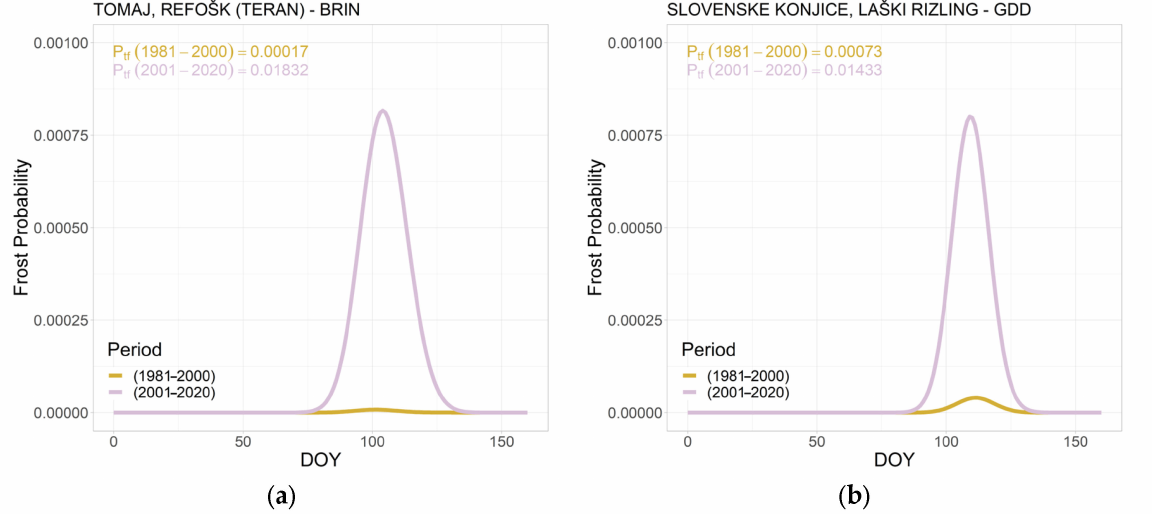
Figure 5. Two examples of modeled results of the probability of spring frost for the analyzed wine- making regions of Slovenia by their climate type: ( a ) sub-Mediterranean climate and the Refošk–Teran variety (Tomaj); and ( b ) subcontinental climate and the Laški Rizling variety (Slovenske Konjice). GDD 5 model results are presented for both